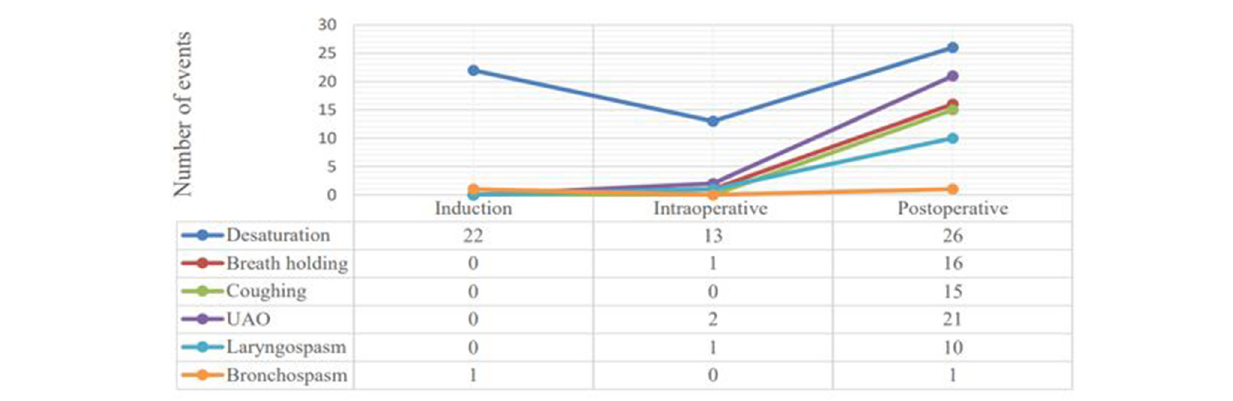
FIGURE 1 | Line graphs showing the frequency of respiratory adverse events among distinct phases of the perioperative period in pediatric surgical patients at UoGCSH and TGSH, Northwest Ethiopia; March 1–May 30, 2020 ( N = 20).